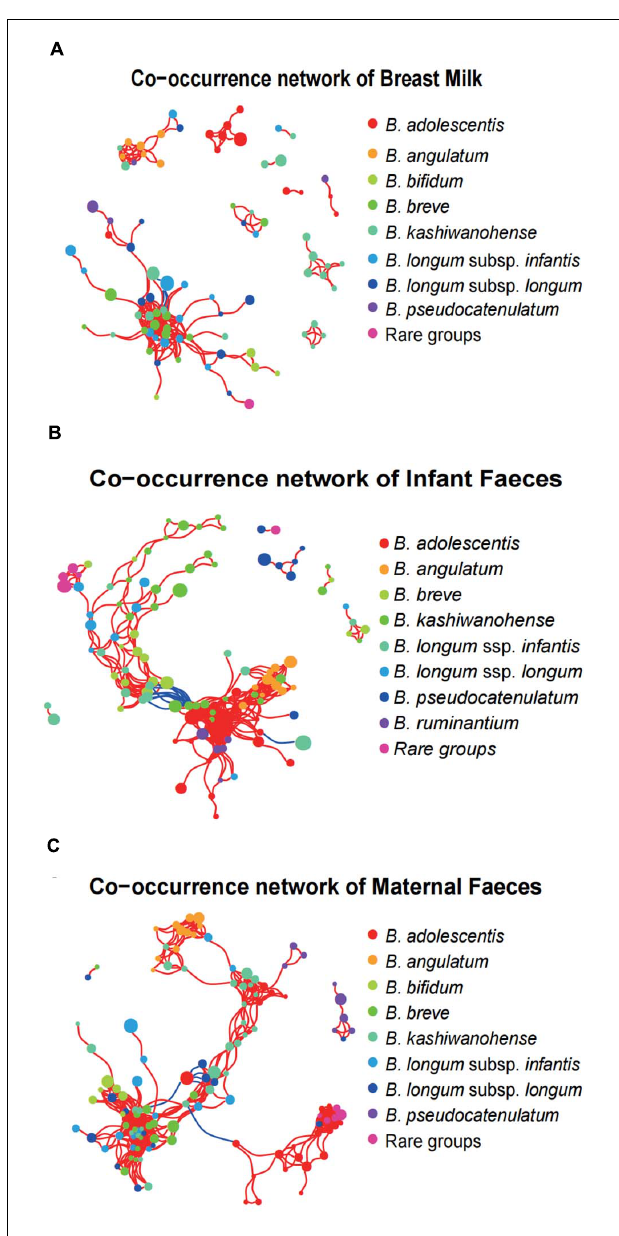
FIGURE 7 | Bifidobacterial co-occurrence networks in the three systems. Co-occurrence networks of Bifidobacterium phylotypes in breast milk (A) , infant feces (B) , and maternal feces (C) . Each node in the network indicates an ASV, and the color represents bifidobacterial phylotypes. Each co-occurring pair among bacterial populations has an absolute Spearman rank correlation above 0.7 [red line: positive correlation ( R > 0.70); blue line: negative (blue) correlation ( R < –0.70)] with an FDR-corrected significance level under